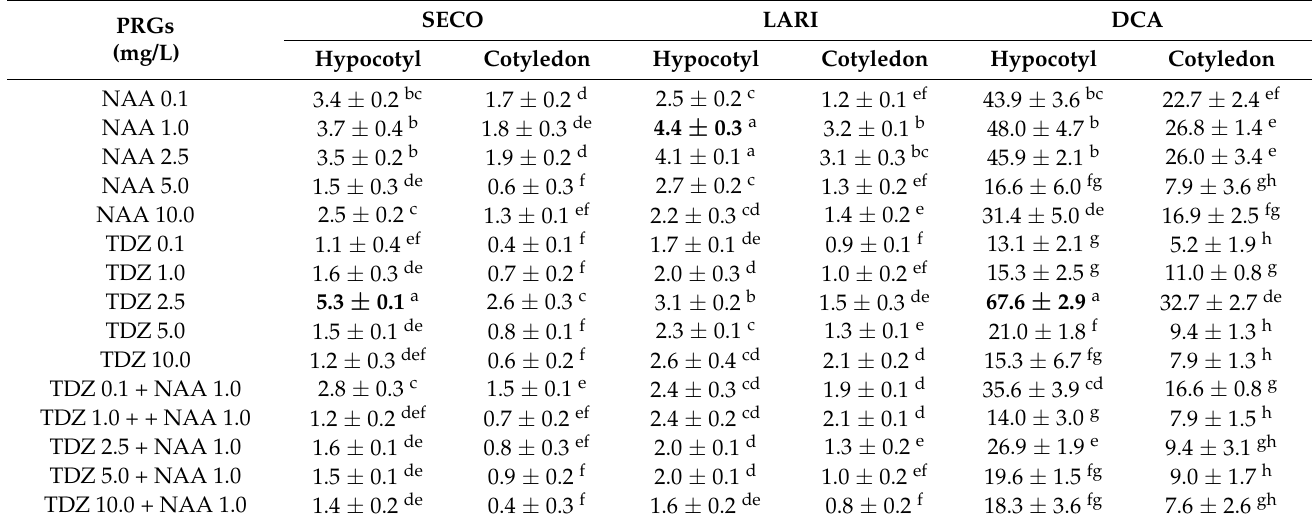
TDZ 5.0 + NAA 1.0 PRGs: plant growth regulators; SECO: secoisolariciresinol; LARI: lariciresinol; DCA: dehydrodiconiferyl alcohol. Values are means ± SD from three replicates expressed in mg/g DW. Highest contents for each compound are indicated in bold. Different superscript letters indicate significant difference ( p <